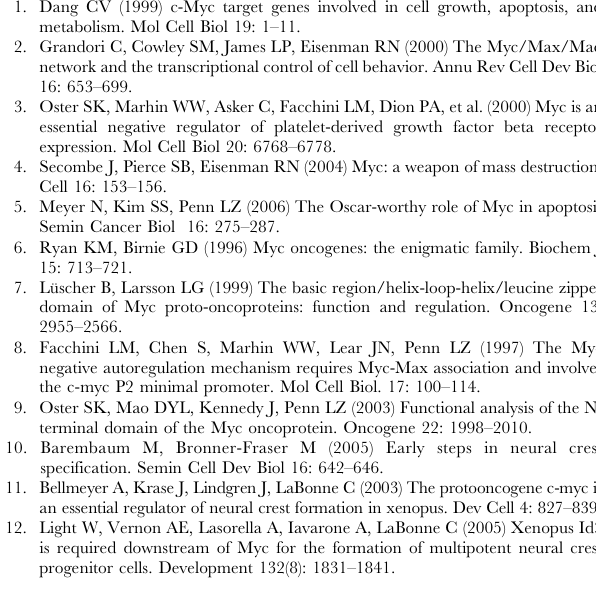
Figure S1 Mych MO specificity. A–B. Mych:GFP signal detection at the bud stage after injection with (B) or without (A) mych UTR MO. C. Schematic drawing of mych SP MO design and two different sets of RT-PCR primers. D–E. RT-PCR shows that the SP MO eliminates the normal mature mRNA